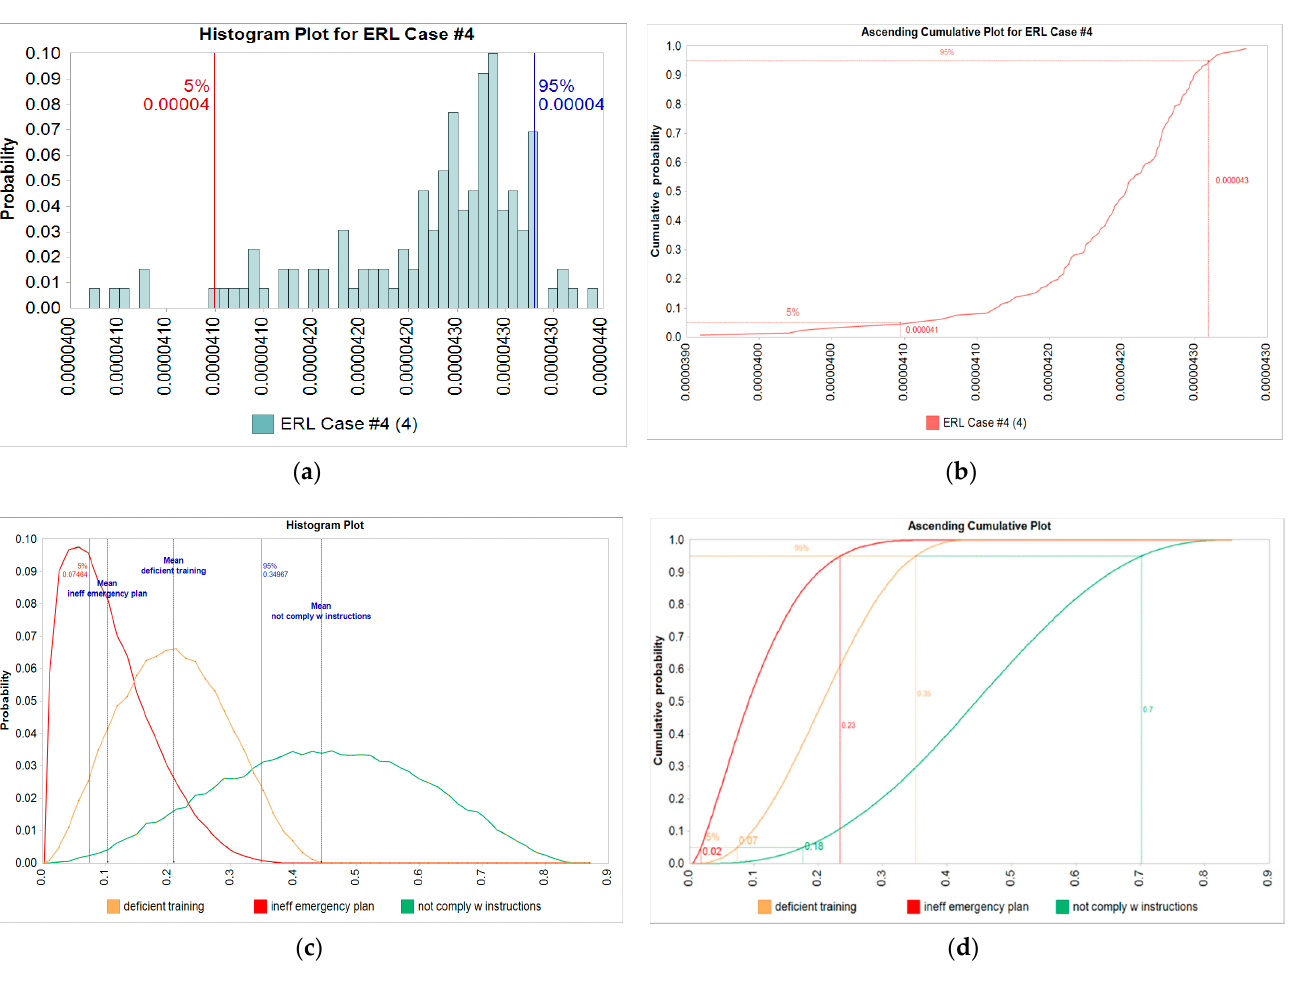
Figure 11. ( a ) Uncertainty analysis of 3 main HOE variables -Case #4. ( b ) Single Cumulative probability plot of ERL Case #4 HOE. ( c ) Probability plots of significant HOEs for Case #4 ( d ) Cumulative distribution plots for significant HOEs –Case #4.